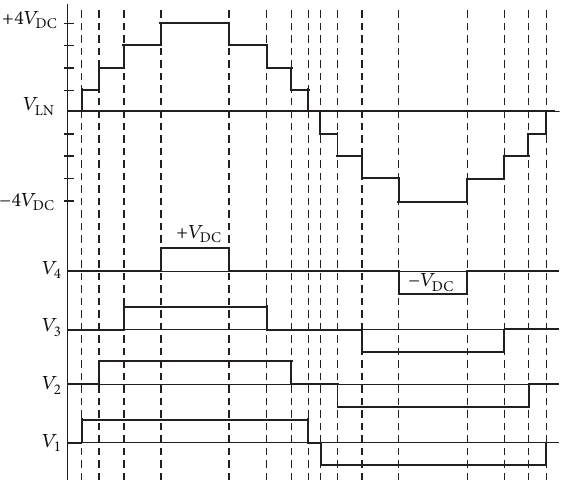
Figure 4: Superposition of the cell voltages for one phase-leg of the 9-level